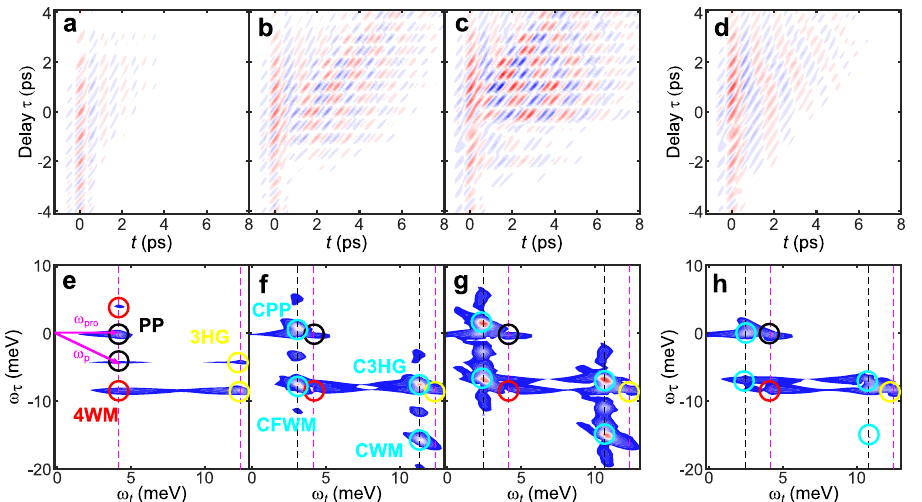
Fig. 2 Multi-dimensional coherent teraherz nonlinear spectroscopy. a – c Nonlinear differential transmission E NL ð t ; τ Þ as a function of sampling time t (real time) and pump-probe delay τ (coherence time) for a low (40.0 kV cm − 1 ), intermediate (100.0 kV cm − 1 ), and high (160.0 kV cm − 1 ) pump driving fi eld. d E NL ð t ; τ Þ for a calculation without pump-probe coherent modulation of the order parameter, δ ∣ Δ pp ∣ = 0. The result is shown for the highest pump fi eld strength of 160.0 kV cm − 1 used here. e – g Two-dimensional (2D) Fourier transform of E NL ð t ; τ Þ from a – c . Labels and circles indicate spectral positions of coherent pump-probe (PP, black circles), four-wave mixing (FWM, red circles), third-harmonic generation (3HG, yellow circles), and correlated high-order wave-mixing (CPP, CFWM, C3HG, and CWM, cyan circles) peaks arising from different nonlinear responses separated in 2D frequency space ( ω t , ω τ ) as discussed in the main text. Vertical magenta (black) dashed lines indicate ω t = ω 0 and ω t = 3 ω 0 ( ω t = ω H ± ω 0 , ω H is the Higgs mode frequency) peaks, which are split in 2D frequency space along the vertical ω τ axis corresponding to the phase coherence time τ . Strong CPP, CFWM, C3HG, and CWM sharp peaks emerge above critical fi eld strength and dominate the conventional peaks (PP, FWM, and 3HG). Magenta arrows indicate the 2D frequency vectors of pump ( ω p ) and probe ( ω pro ) pulses in e . h Two-dimensional Fourier transform of E NL ð t ; τ Þ from d . Despite the same strong pump excitation as g , the correlated high-order wave-mixing peaks are absent for δ ∣ Δ pp ∣ = 0 even for the highest fi elds. Without δ ∣ Δ pp ∣ , the results agree with previous results in semiconductors or the results obtained from the third-order nonlinear response (compare e and h ). The distinct correlated wave-mixing peak (CWM) in the right bottom corner of the 2D space, seen in f and g , is generated only when δ ∣ Δ pp ∣ ≠ 0 and presents the most dramatic experimental signature of light- induced higher-order correlation in THz-time periodic-driven superconducting quantum